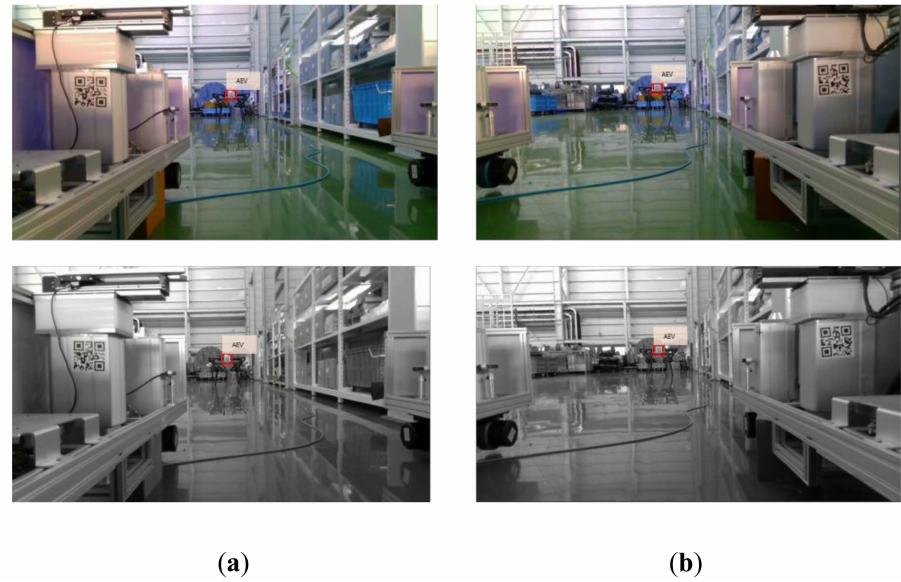
Figure 14. AEV’s marker recognized at a distance of 11 m from the mobile station. ( a ) Left Camera Image, ( b ) Right Camera